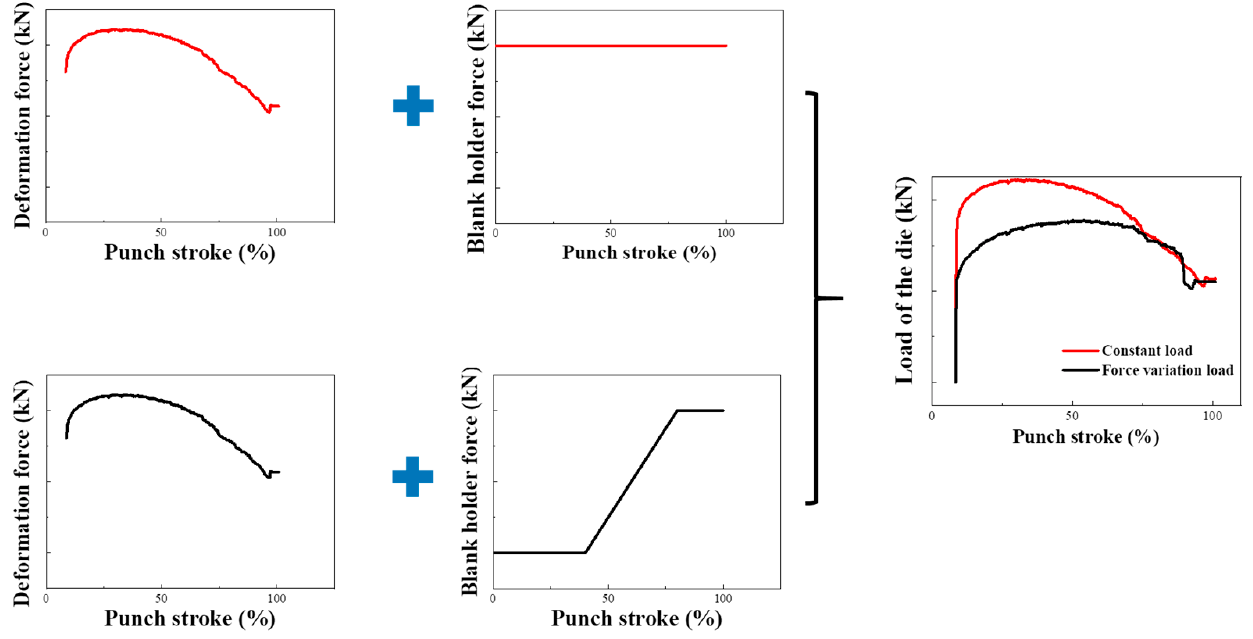
Figure 15. Difference of mold load between variable load and constant load.